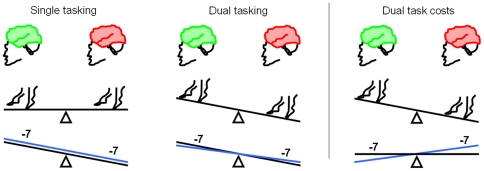
Good versus poor trail making test performers: overview of differences in single and dual tasking behaviour, and in dual task costs.Under challenging conditions, older persons with good Trail Making Test (TMT) performance (good cognitive flexibility and working memory; green brain, left) perform comparably well as poor TMT performers (red brain, right) regarding walking velocity, but better on a cognitive single task which is associated with executive functioning (subtracting serial 7 s). The black line represents subtraction velocity and the blue line subtraction errors. Under dual tasking conditions (maximum walking speed and subtracting serial 7 s with maximum speed), poor performers walk more slowly than good TMT performers. Velocity of the serial −7 s task is still lower in the poor TMT performers, but the difference in number of errors between good and poor TMT performers is smaller than under single task conditions. This is also reflected in the dual task costs: Regarding the walking task, dual task costs are higher in poor TMT performers than in good TMT performers. However, dual task costs of velocity of the serial −7 s task are not significantly different, and dual task costs of subtraction errors are even lower in poor TMT performers than in good TMT performers. This demonstrates that older persons with poor cognitive flexibility and working memory prioritize differently to those with good cognitive flexibility and working memory when performing a challenging dual task paradigm with a walking and a cognitive task.